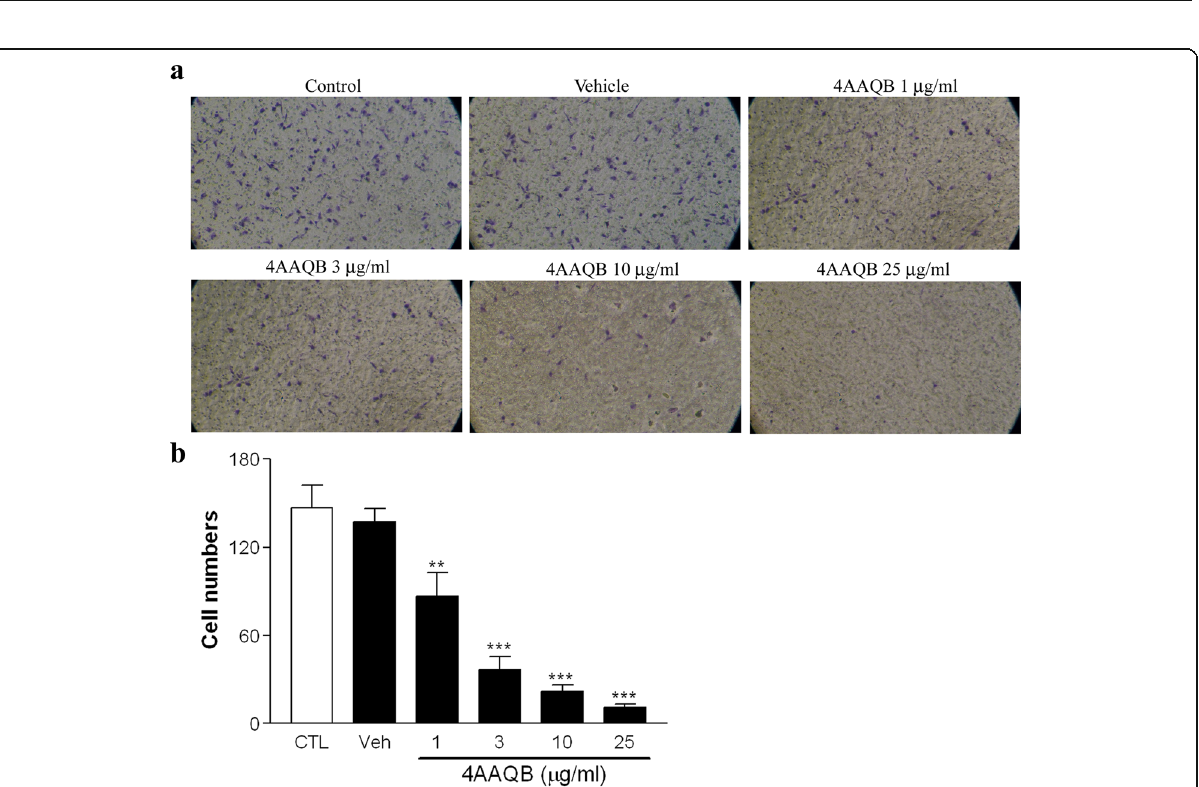
Fig. 3 Effect of 4AAQB on LPS-induced cell migration of murine macrophages. Peritoneal macrophages were pretreated with various concentrations of 4AAQB for 30 min and then activated with LPS. The results of cell migrated through gelatin-coated transwells for 20 h were shown ( a ), and the mi- grated cells were counted ( b ). Data are expressed as the mean±S.E.M of three independent experiments. ** p <0.01 and *** p <0.001 as compared with LPS-treated control groups